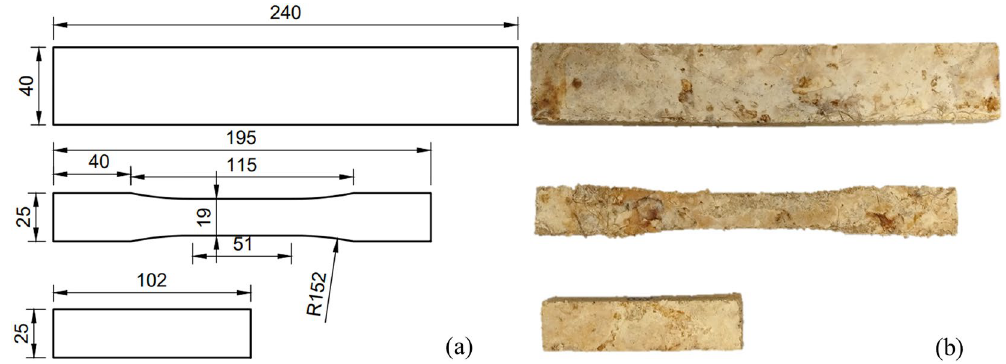
Figure 1. Testing specimens: ( a ) dimensions of testing samples and ( b ) test specimens for flexural, tensile and compression testing (from top to